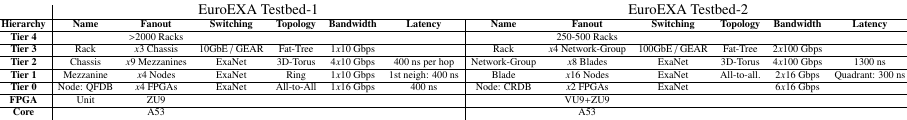
Figure 2. TB2 blade and QUAD-DB partition.